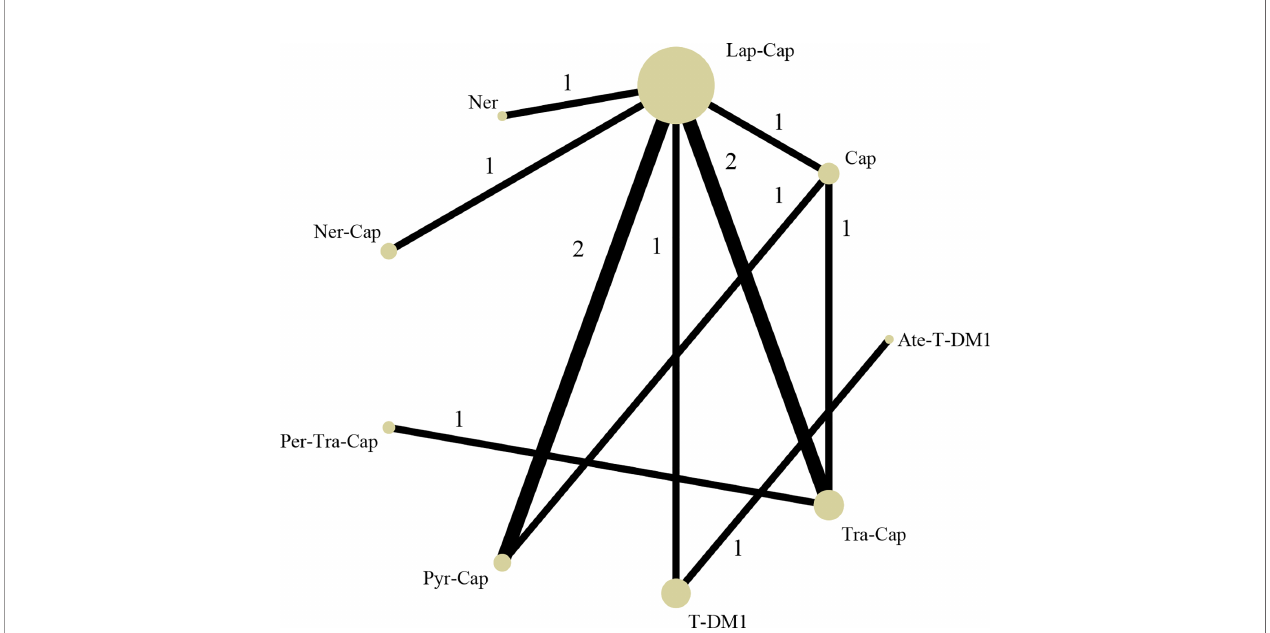
FIGURE 3 | Network structure diagram. T-DM1, trastuzumab emtansine; Lap, lapatinib; Tra, trastuzumab; Cap, capecitabine; Ner, neratinib; Per, pertuzumab; Pyr, pyrotinib; Ate,